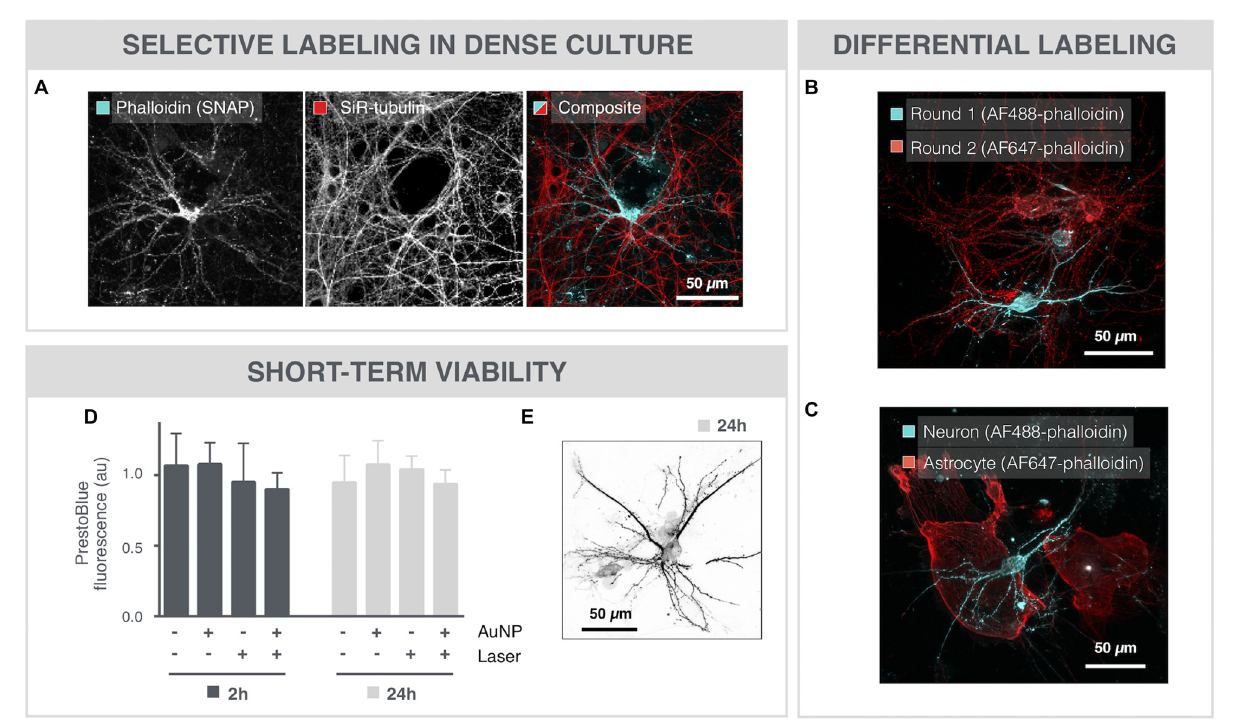
FIGURE 2 | SNAP-assisted phalloidin labeling is selective and non-cytotoxic. (A) Microscopic image of an 18 DIV neuron that was selectively labeled with image-guided SNAP. The complete network is labeled with the membrane-permeable dye SiR-tubulin, whereas only the targeted neuron is labeled with phalloidin. (B) Repetitive SNAP procedure with two chromatic phalloidin variants (AF488, AF647) allows multicolor labeling of individual neurons in the same field of view. (C) The same procedure was used to selectively label astrocytes and neurons in different colors in the same culture. (D) Quantification of cell viability after 2 and 24 h shows no significant toxicity induced by the AuNPs or the 561 laser pulses, nor of the combination of both. (E) Microscopic image of a neuron, 24 h after SNAP-assisted phalloidin labeling.